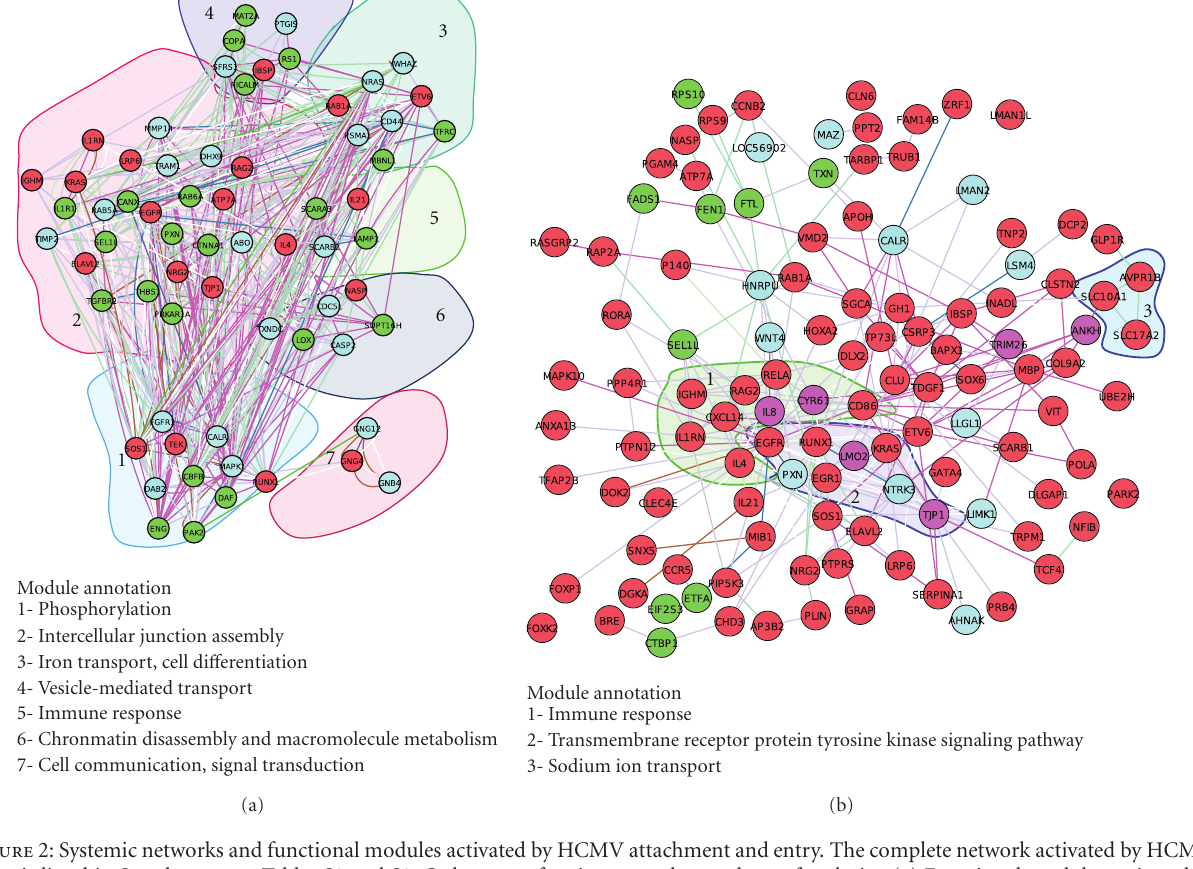
Figure 2: Systemic networks and functional modules activated by HCMV attachment and entry. The complete network activated by HCMV entry is listed in Supplementary Tables S2 and S3. Only parts of entire networks are shown for clarity. (a) Functional modules activated at 5min PI; (b), activated network at 25min